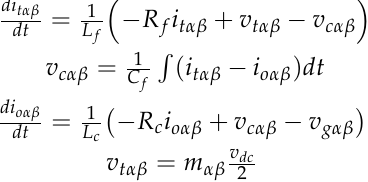
Figure 9. The diagram of the nonlinear model of the BDC combined with: ( a ) PV and ( b ) SC models.